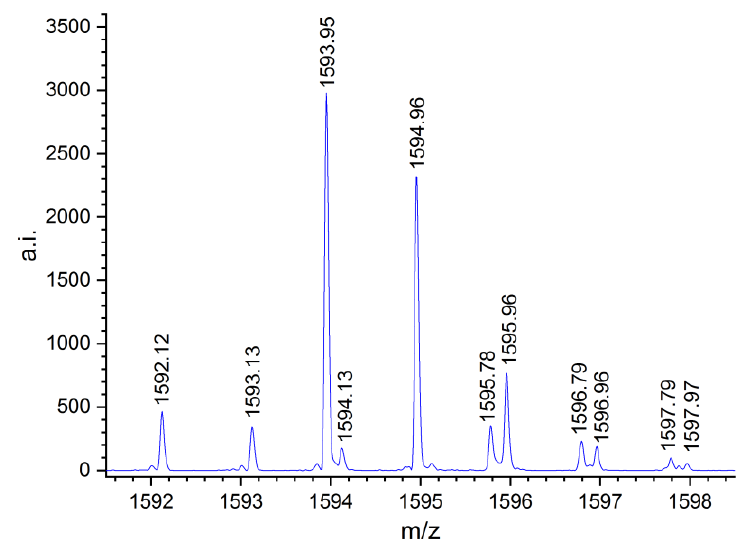
Figure 8. Expansion of the MALDI-TOF MS spectrum showing a region for m/z = 1591.5–1598.5.